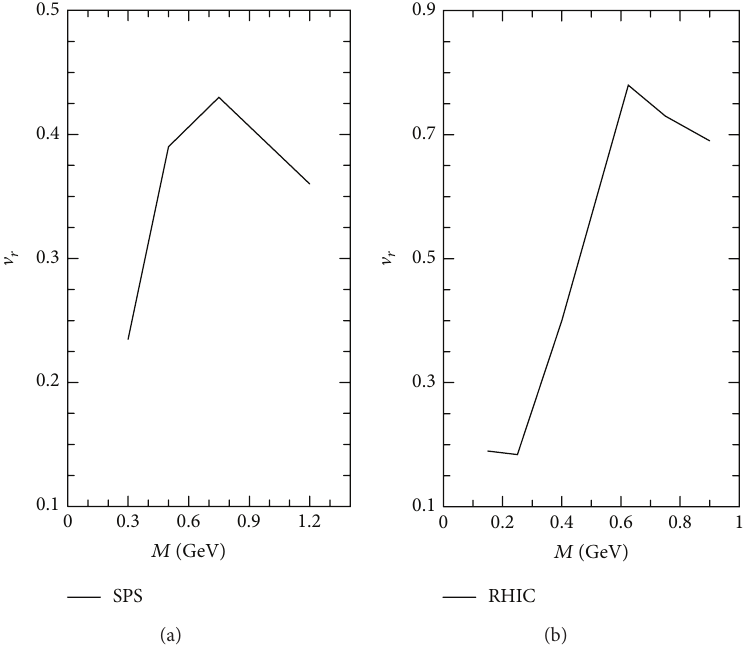
Figure 29: The variation of radial flow with invariant mass pairs for SPS (a) and RHIC (b) energies.